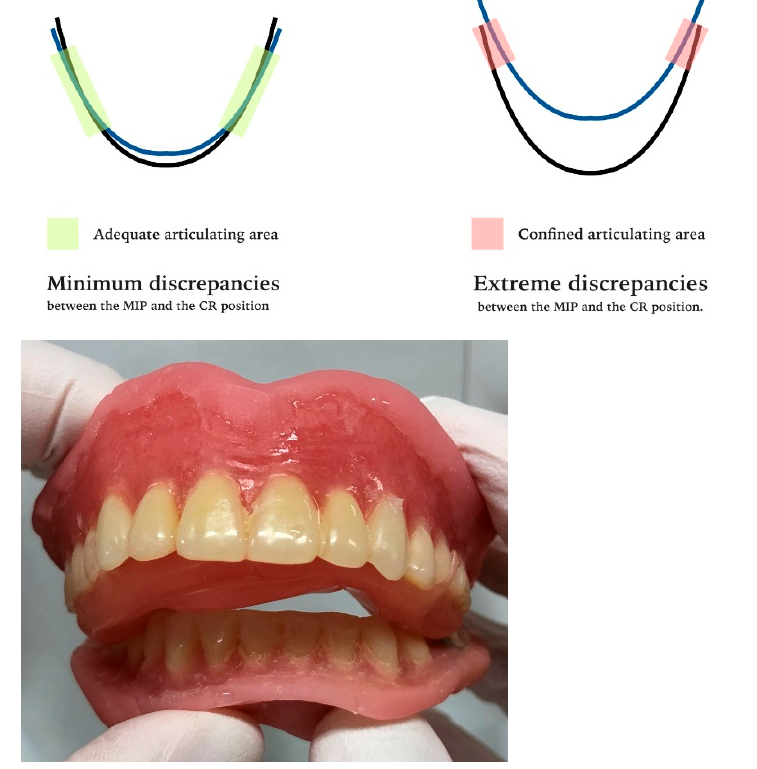
Figure 3. A case in which the clinical remount procedure is contraindicated on existing dentures. The extreme anterior–posterior discrepancy between the maximal intercuspal position (MIP) and the centric relation (CR) had reduced the posterior occlusal supporting areas, making it more difficult to stabilize the adjusted dentures.